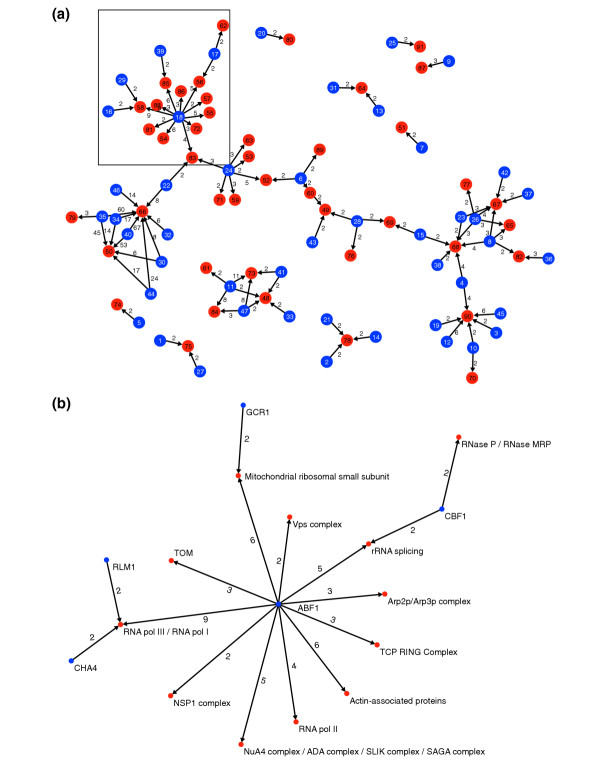
A thematic map of regulonic complexes. (a) Here, blue nodes represent transcription factors, red nodes represent protein complexes, and a link is drawn between a transcription factor and a protein complex if the promoters of a significantly large number of complex members are bound by the transcription factor. (b) An enlarged region of the regulonic complex map in (a). Links between transcription factors and the complexes they regulate are labeled with the numbers of supporting interactions in the transcription regulation network. For lists of transcription factors and complexes in the map see Additional data files 5 and 6.